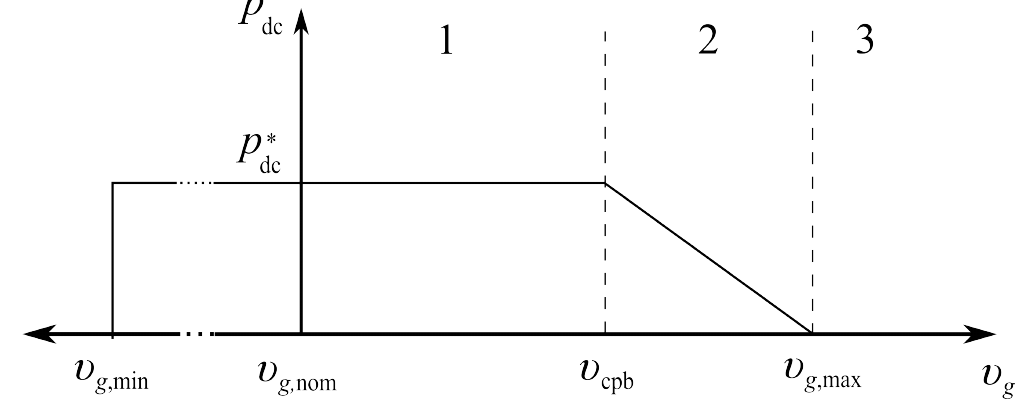
Figure 1. Active power drooping based on the work in